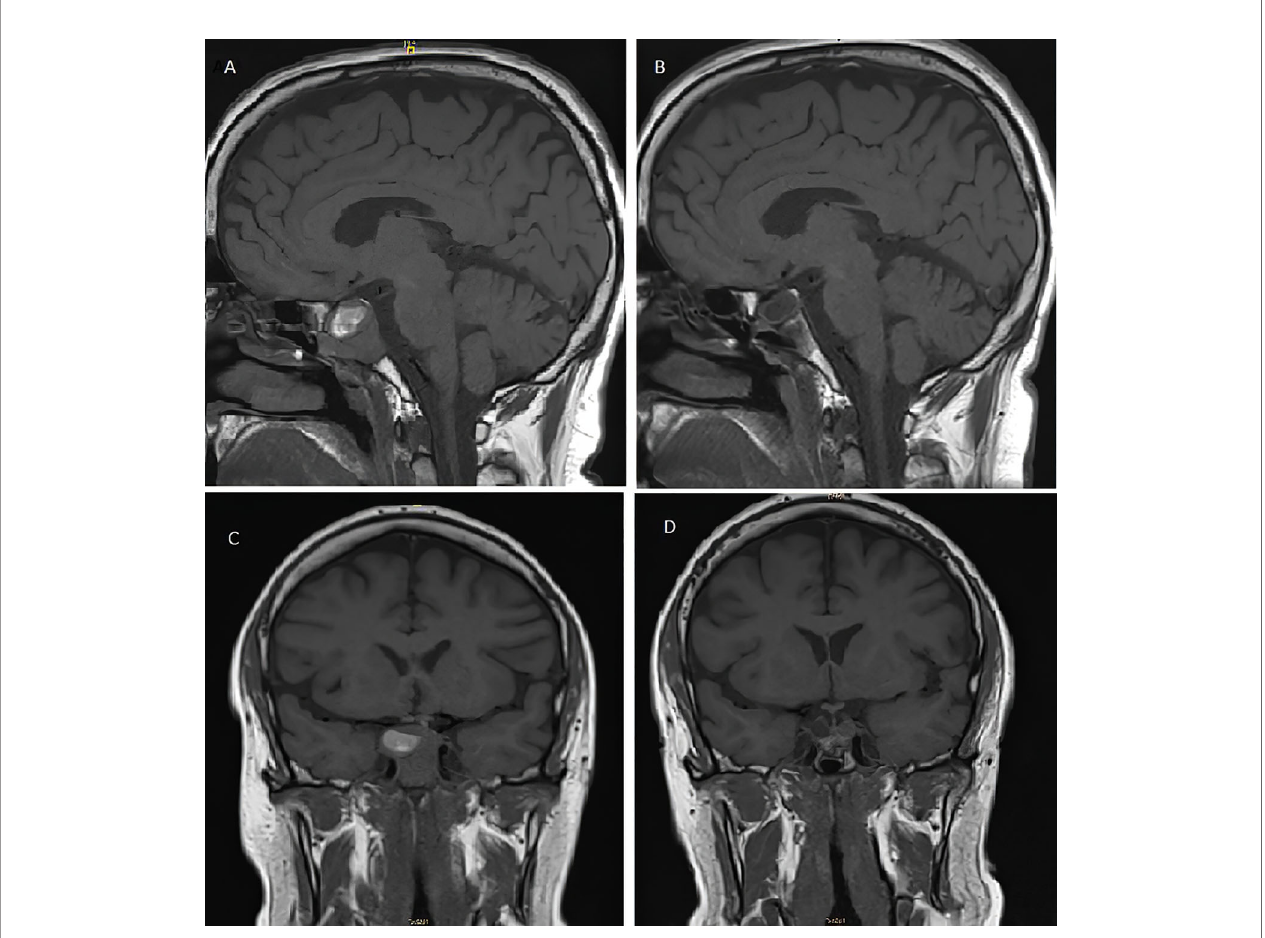
FIGURE 2 | T1-weighted pituitary magnetic resonance imaging before (A, C) and after (B, D) treatment with capecitabine and temozolomide. (A) Pre-CAPTEM sagittal image shows an increase in the size of the seal tumor (26 mm) with a subacute bleeding component. (B) Post-CAPTEM sagittal image shows a decrease of 65% with a total size of 9 mm. (C) Pre-CAPTEM pituitary coronal image shows invasion of clivus and protrusion into the sphenoid sinus. (D) Post-CAPTEM coronal image shows a decrease in size of the lesion, more prominent at the right